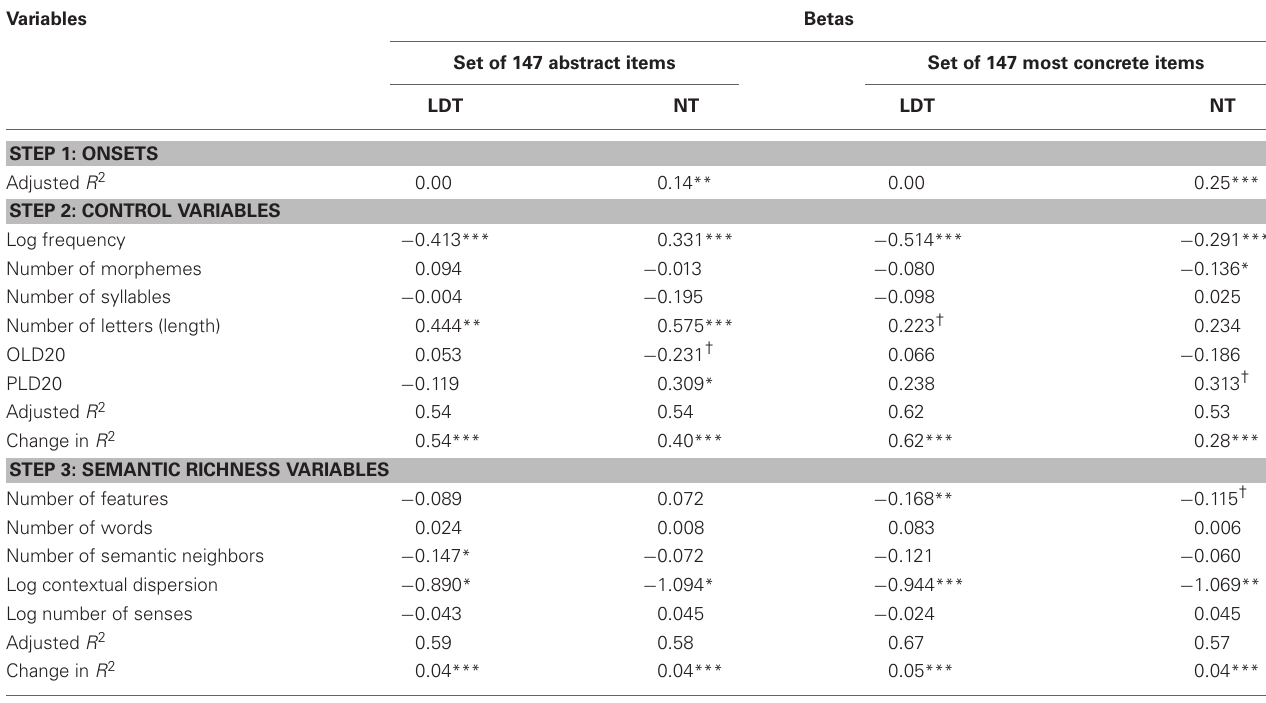
Table 4 | Standardized regression coefficients predicting lexical decision and naming